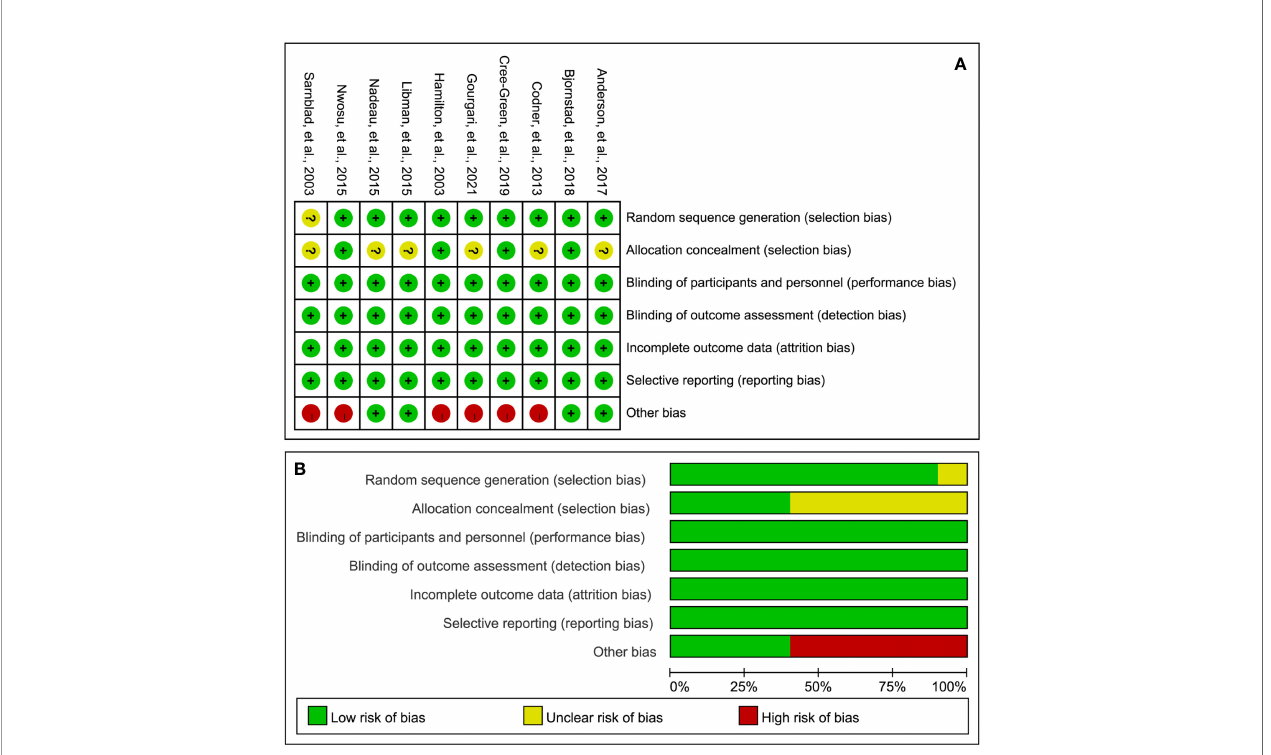
FIGURE 2 | RoB summary (A) and graph (B). “ + ” , “ ? ” , and “ - ” represent “ low ” , “ unclear ” , and “ high ” risk of bias,